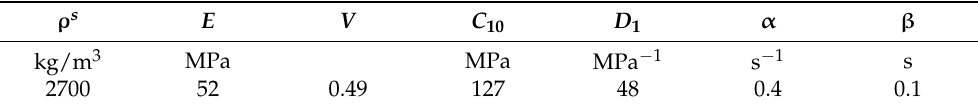
Table 2. Material parameters of the